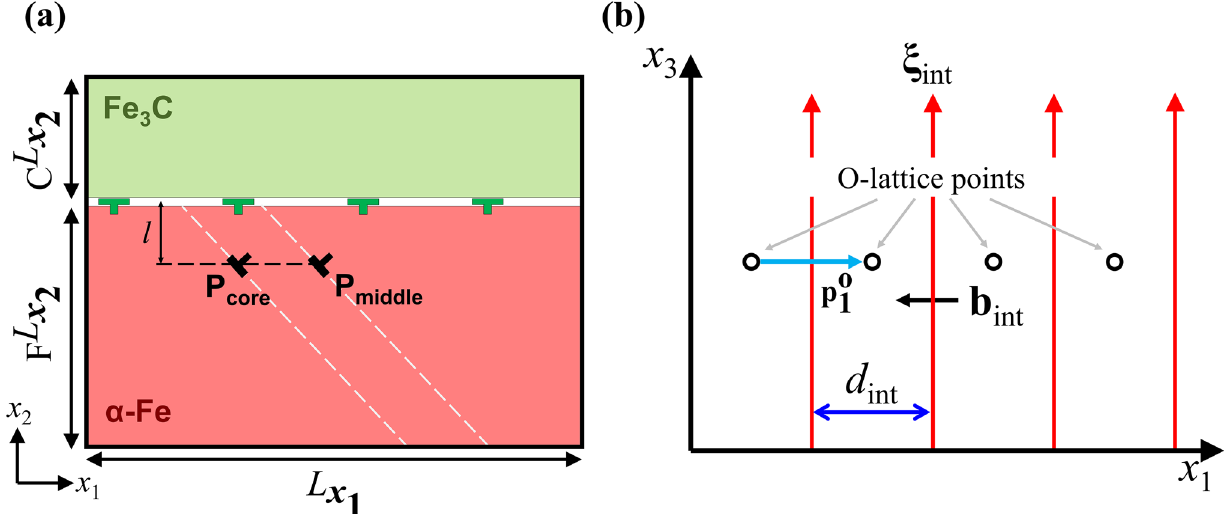
Figure 1. Schematic representation of ( a ) the ferrite/cementite bilayer model for an Isaichev (IS) orientation relationships with a straight lattice dislocation in the ferrite layer and ( b ) the arrays of misfit dislocations and its O-lattice